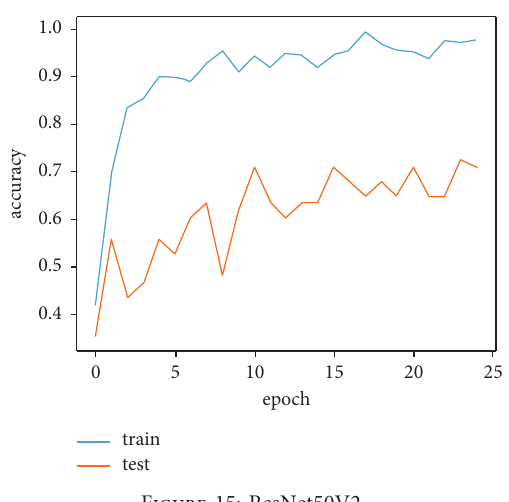
Figure 14: ResNet-50. Figure 15: